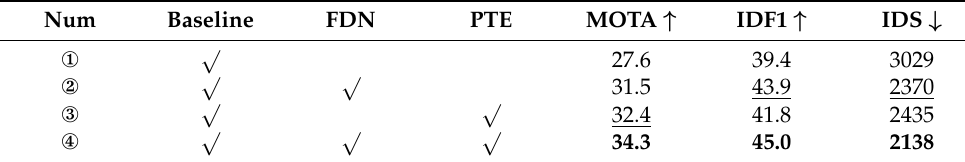
Table 4. Ablation analysis of the FPUAV on